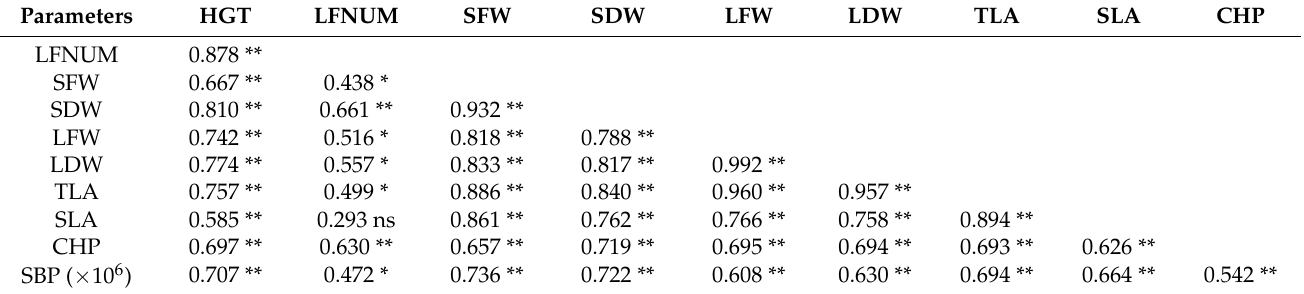
Table 6. Pearson correlation coefficients between plant growth parameters and soil bacterial population.